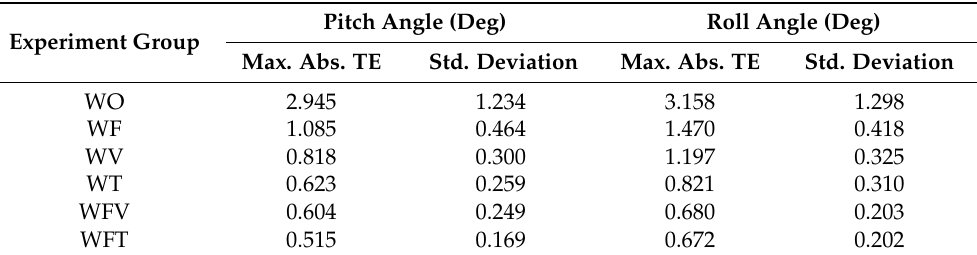
Table 4. The attitude regulation results of different control